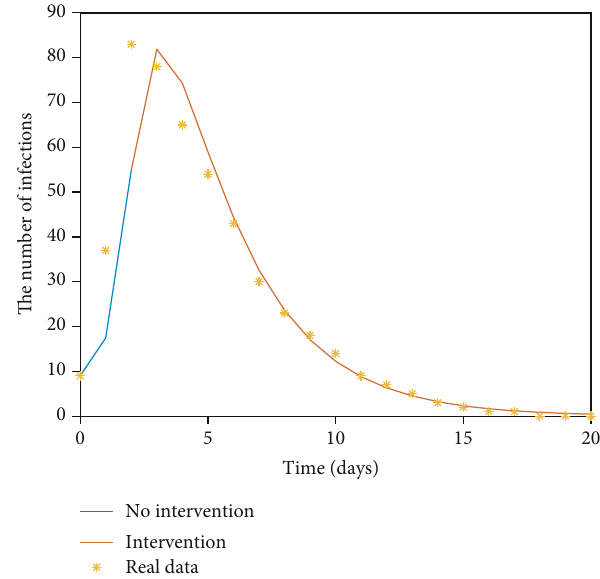
Figure 1: Quantity of the Norovirus infections I ð t Þ compare with the numerical results of integer-order SEIAR model (1) obtained by the MGAM method and g = 7 : 9138